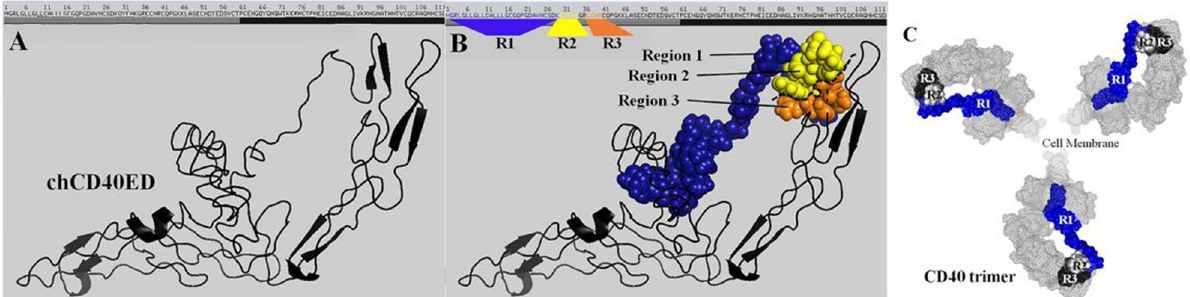
Figure 4. Virtual tertiary structure of chCD40ED showing the potential aptamers linking sites. PyMOL 2.2 software (https ://pymol .org/2/) was used for modeling and visualization. ( A ) Cartoon modeling shows the tertiary structure of the protein. ( B ) Space-filling model representing the virtual aptamers-protein interaction sites. Three regions (blue, yellow and orange) determined by MALD-TOF–MS experiment. The blue region represents long flabby peptide sequence where CD40L attach. ( C ) Top view of the 3D structure of the chCD40ED. This model shows virtual trimer configuration of CD40 receptor (Mesh model, gray) with